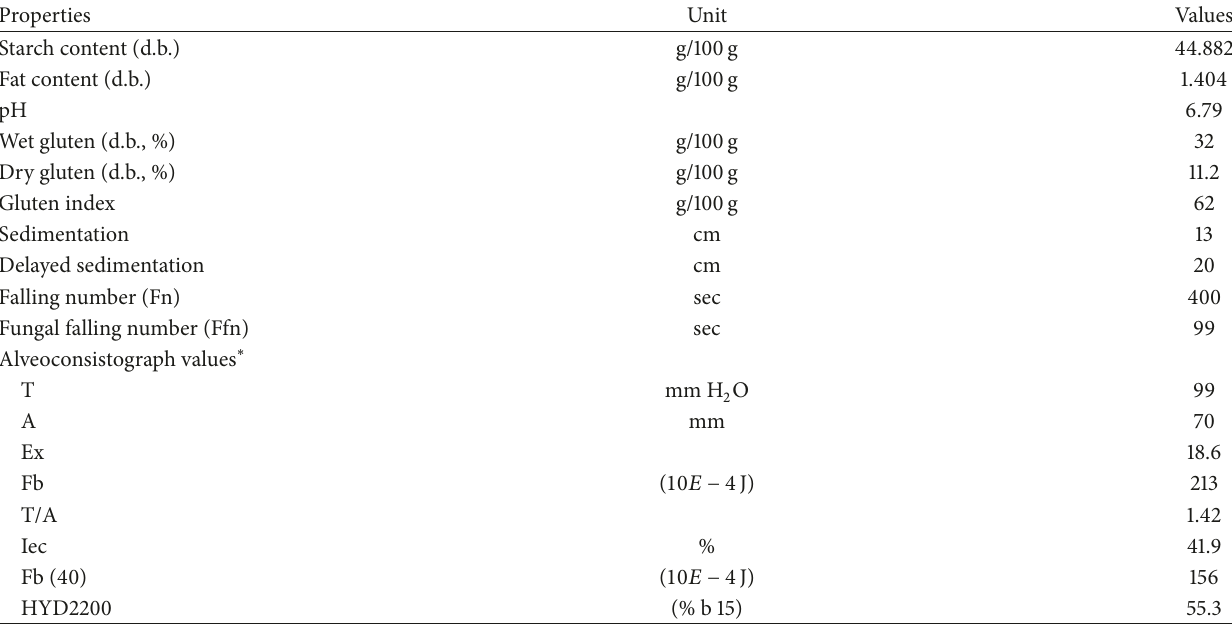
Table 2: Properties of raw material (Durum wheat).